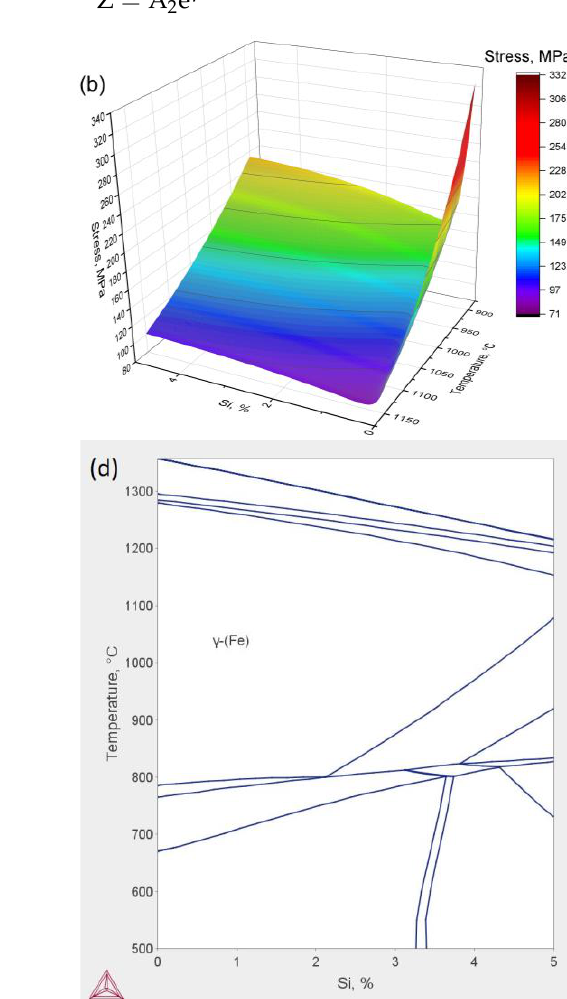
Figure 7. Calculated dependence of the true stress on the temperature and Mn ( a ) and Al ( b ) con- tents at a strain rate of 1 s – 1 and a true strain of 0.7. The phase diagrams of the Fe – xMn – 8Al – 1C ( c ) and Fe – 28Mn – xAl – 1C ( d ).